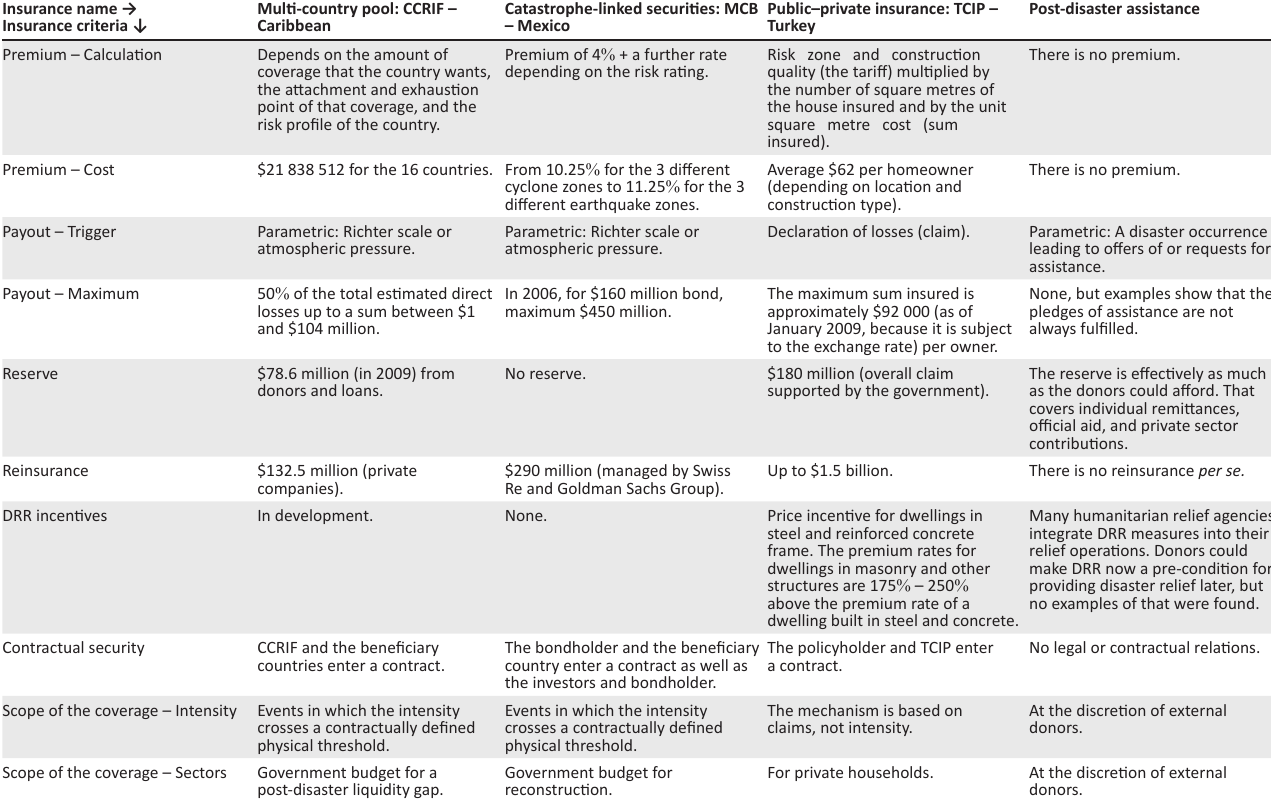
TABLE 1: Comparing public insurance mechanisms to be considered for Pacific Small Island Developing